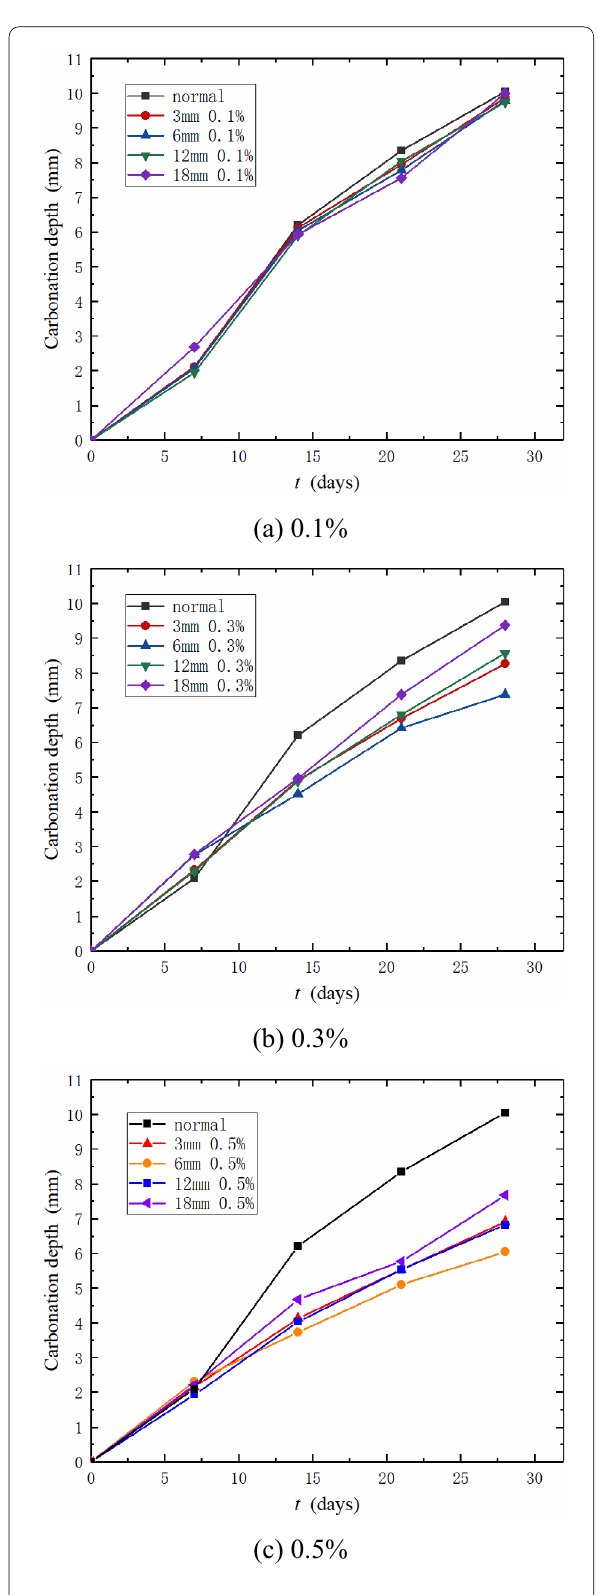
Fig. 4 Time evolution of carbonation depth in PVA fiber concrete with fiber contents of 0.1%, 0.3% and